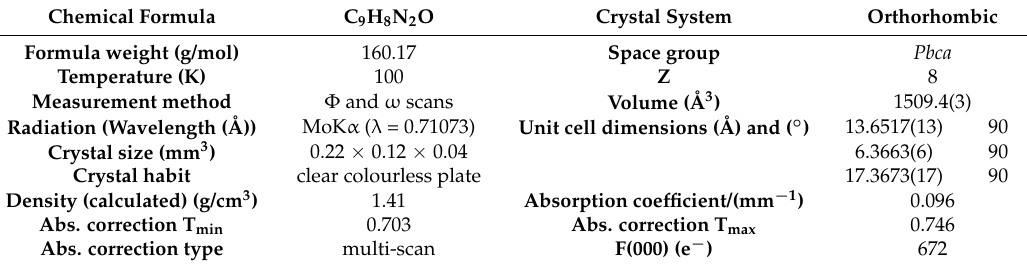
Figure 9. Asymmetric unit of 1 , drawn with 50% displacement ellipsoids. Table 2. Sample and crystal data of 1 .